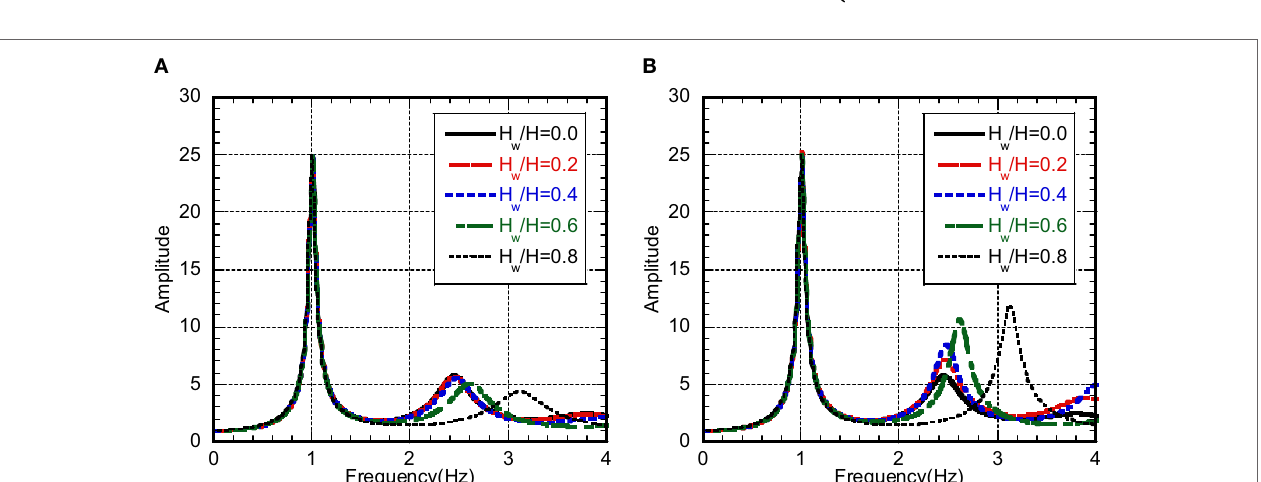
FIGURE 3 | Transfer function: (A) proportional damping and (B) concentrated damping.